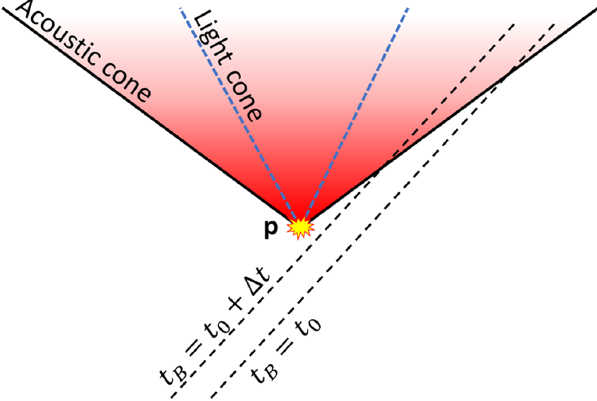
FIG. 6. Minkowski diagram of the “ acoustic-cone argument. ” An external source at p (yellow star) generates a perturbation in the medium, which propagates within the outermost character- istic cone of the field equations (acoustic cone) and decays by dissipation as we move away from the source. If the field equations are acausal, the acoustic cone extends outside the light cone. Hence, there is an observer Bob in whose frame the perturbation exists before p has occurred. On the region f t B < t B ð p Þg , Bob observes a solution of the sourceless field ≪ t p Þ but grows equations, which is at equilibrium for t B B ð p Þ from spontaneously as t approaches t B B ð